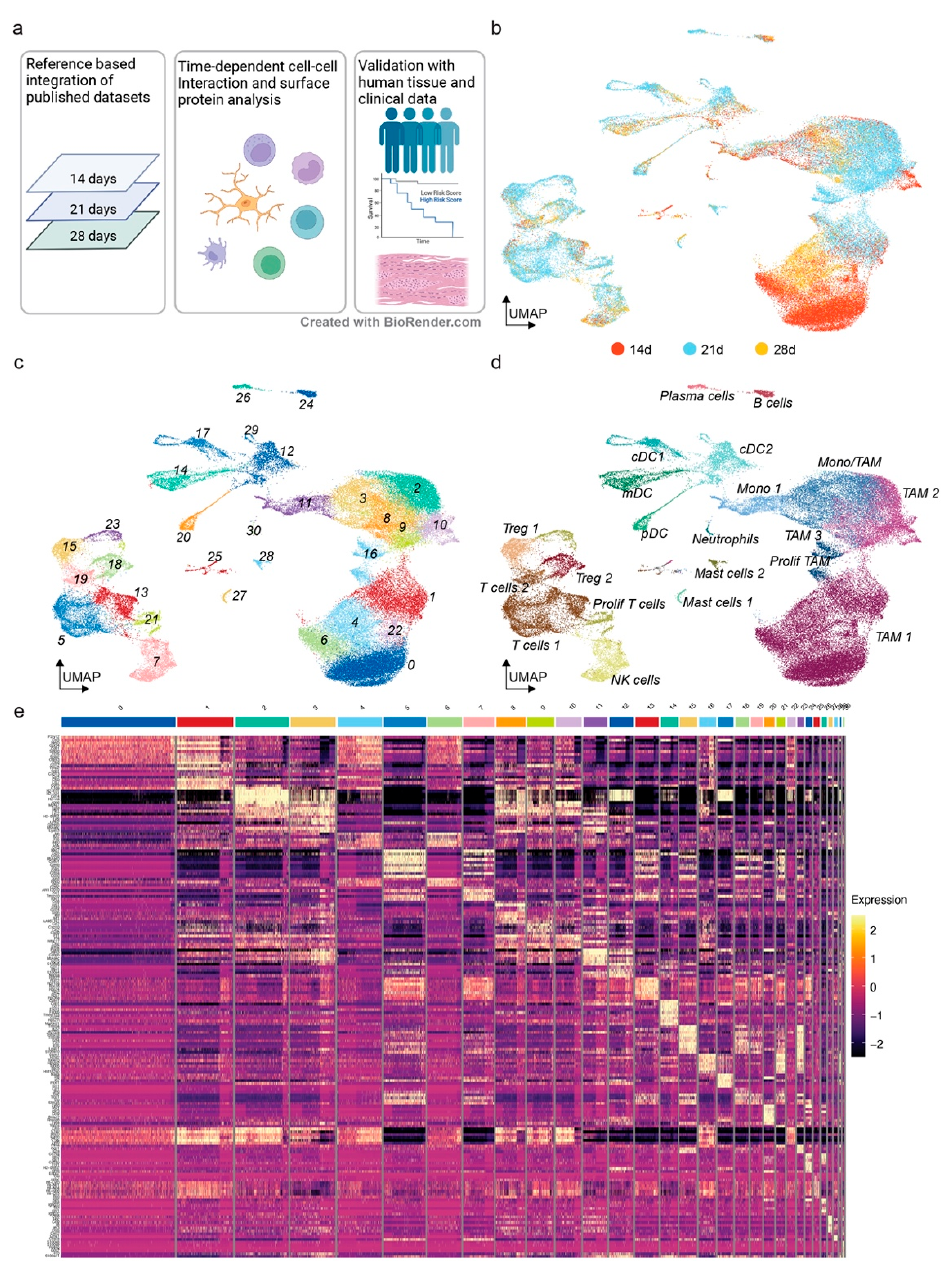
Figure 1. Integration of three GL261 murine orthotopic glioma single-cell RNA-sequencing datasets to analyze tumor progression. ( a ) Schematic illustration of the workflow of the present study. ( b ) UMAP visualization of the integrated dataset (n = 61,814) color-coded by time point. ( c ) UMAP visualization of the integrated dataset color-coded by cluster. ( d ) UMAP visualization of the integrated dataset color-coded by cell type. ( e ) Heatmap visualization of the top 10 marker genes per cluster. The color coding of the respective clusters is consistent with panel c. The color scale indicates the Pearson’s residuals from a negative binomial regression.